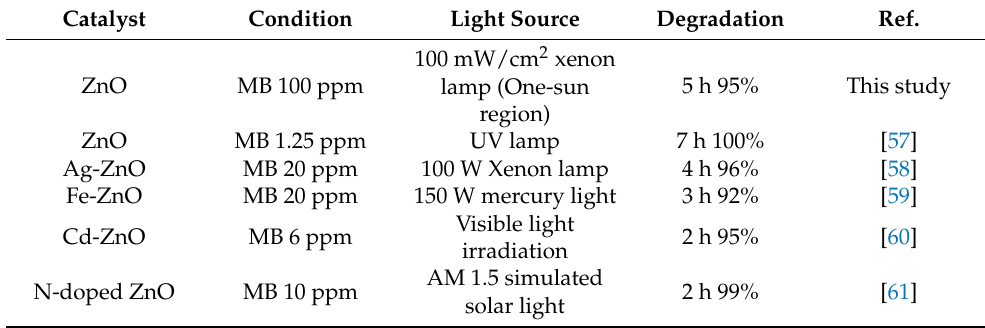
Table 1. Comparative study of photocatalytic degradation of MB under visible light. Catalyst Condition Light Source Degradation Ref. 100 mW/cm 2 xenon ZnO MB 100 ppm 5 h 95% This study lamp (One-sun region) ZnO MB 1.25 ppm UV lamp 7 h 100% [57] Ag-ZnO MB 20 ppm 100 W Xenon lamp 4 h 96% [58] Fe-ZnO MB 20 ppm 150 W mercury light 3 h 92% [59] Visible light Cd-ZnO MB 6 ppm 2 h 95% [60] irradiation AM 1.5 simulated N-doped ZnO MB 10 ppm 2 h solar light